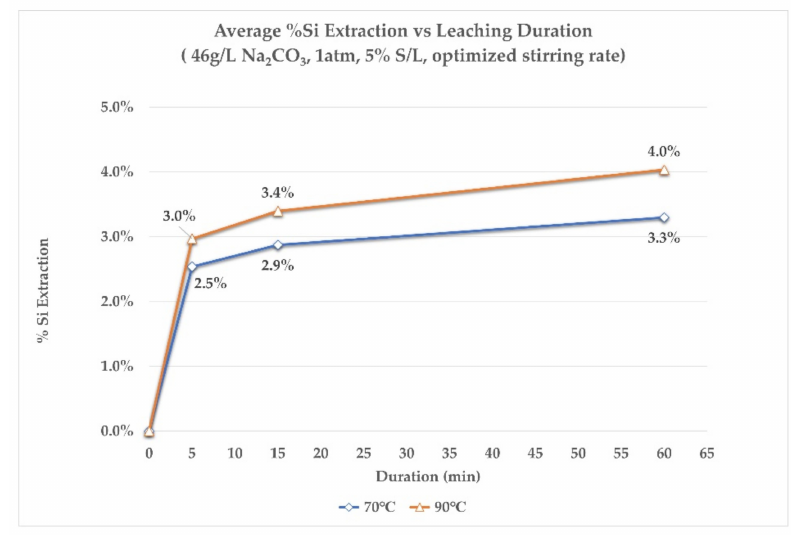
Figure 7. The %Si extraction rate at different leaching times, at 70 ◦ C and 90 ◦